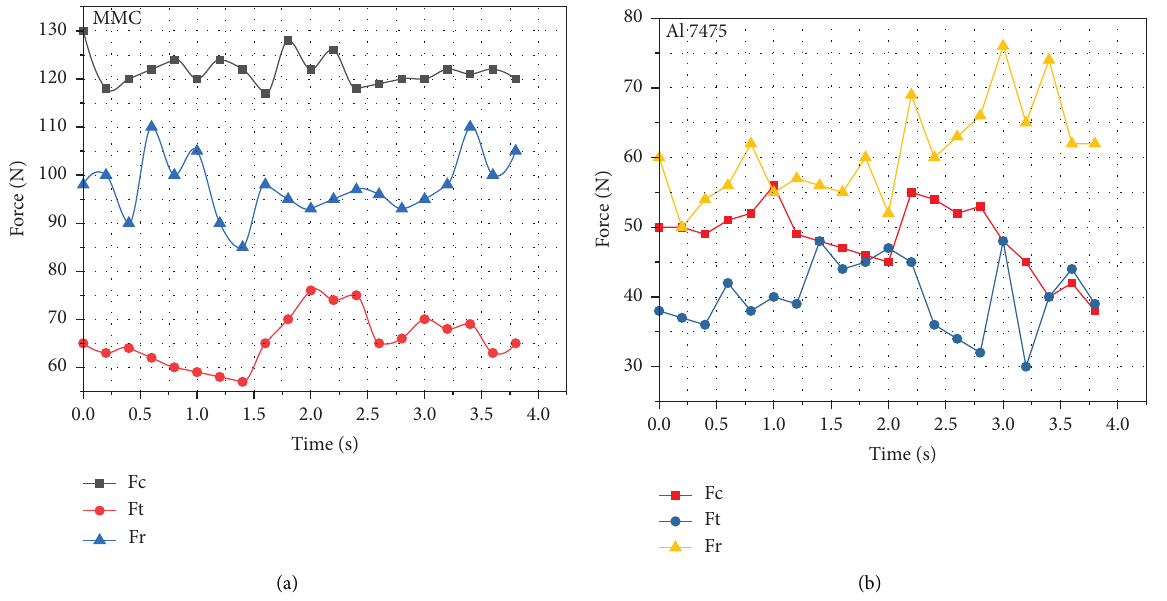
Figure 4: Comparison of force signals. (a) MMCs. (b) 7475 ( V � 90m/min, f � 60mm/min, a